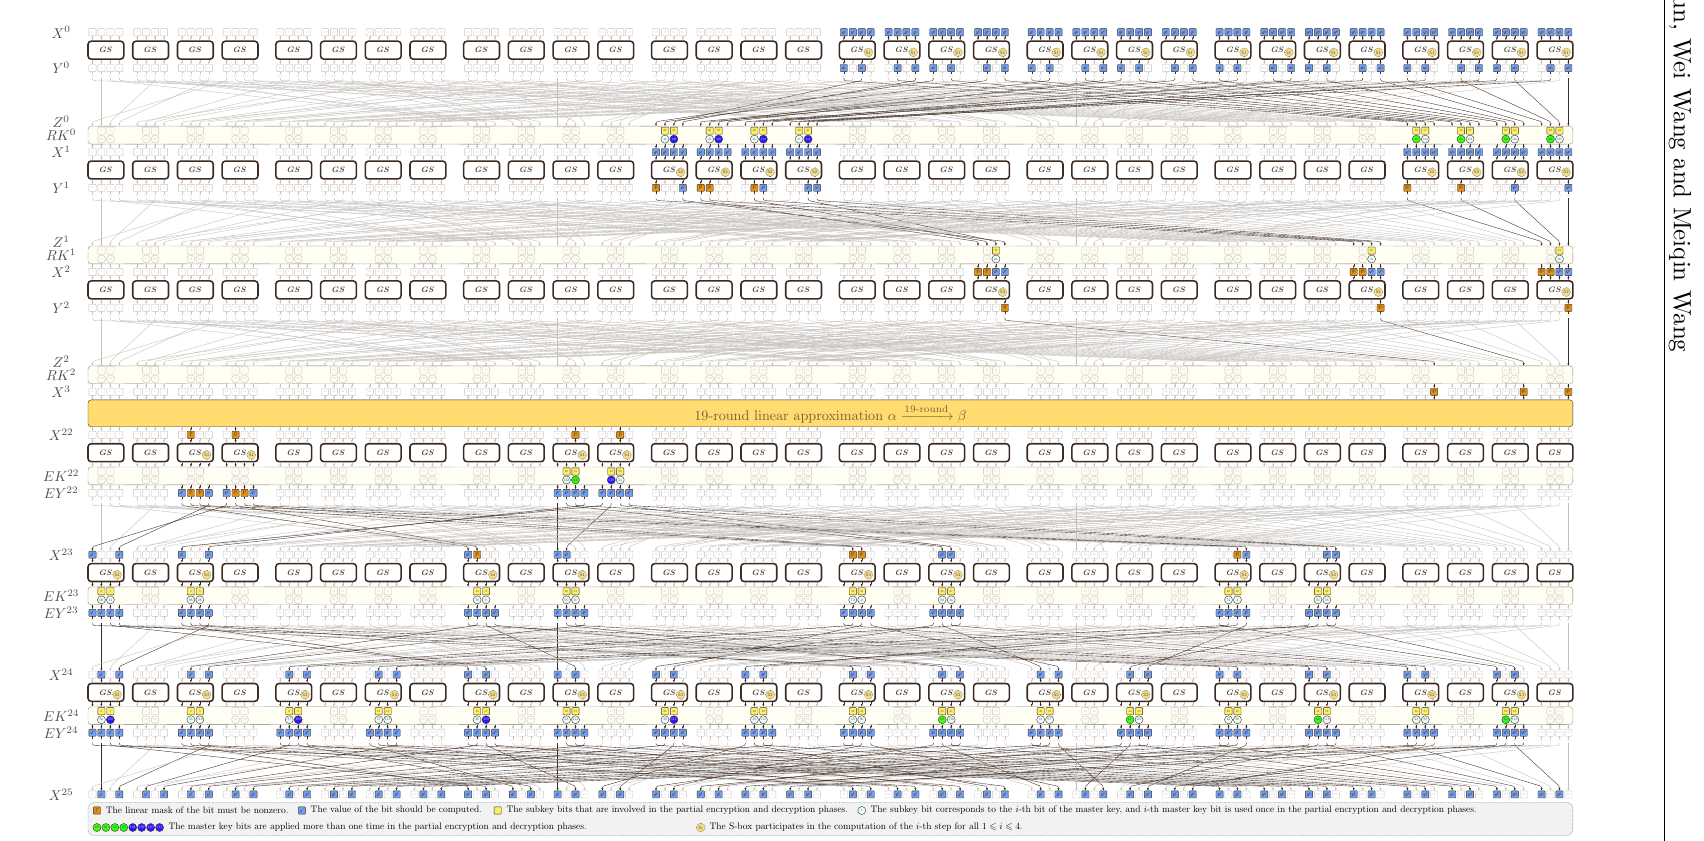
S i TheS-boxparticipatesinthecomputationofthe i -thstepforall1 6 i 6 4.